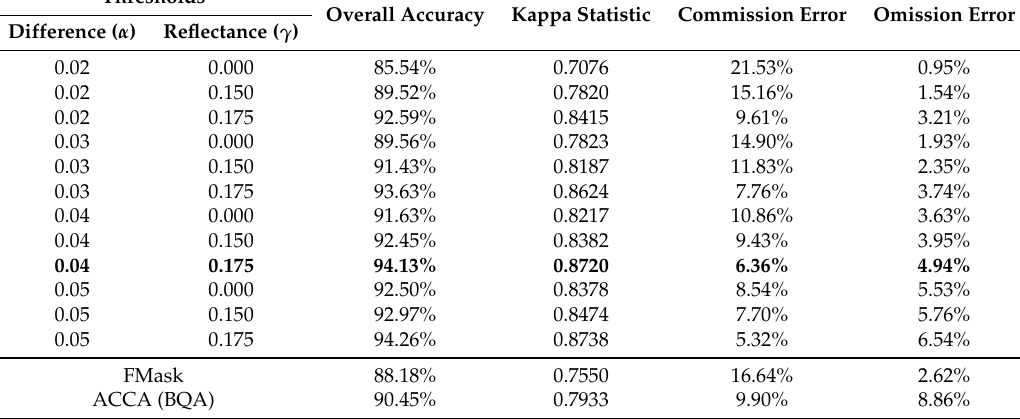
Table 3. Cloud detection statistics for different thresholds combinations over all selected pixels of the Landsat-8 Biome Dataset, using the median as background estimation